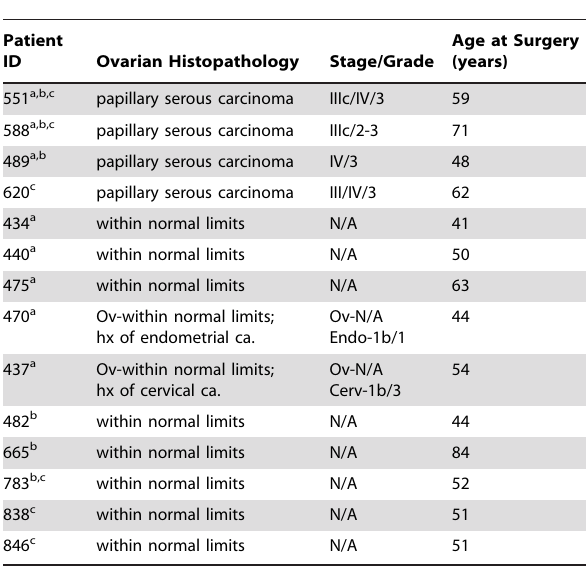
Table 1. Clinical information of patient samples used in this